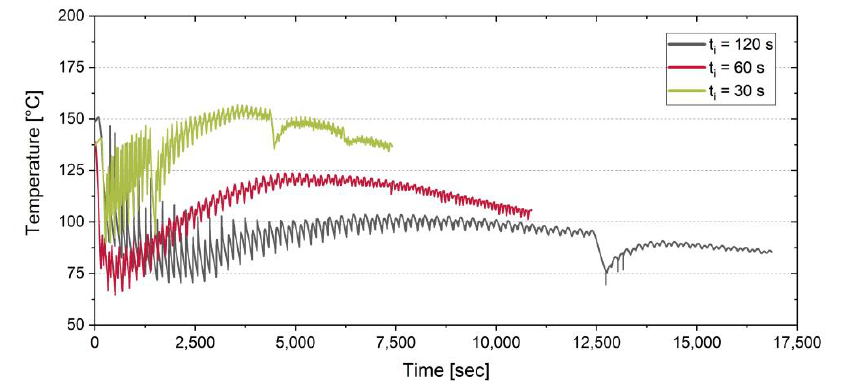
Figure 3. Temperature distribution on the baseplate by example of Series B specimen.